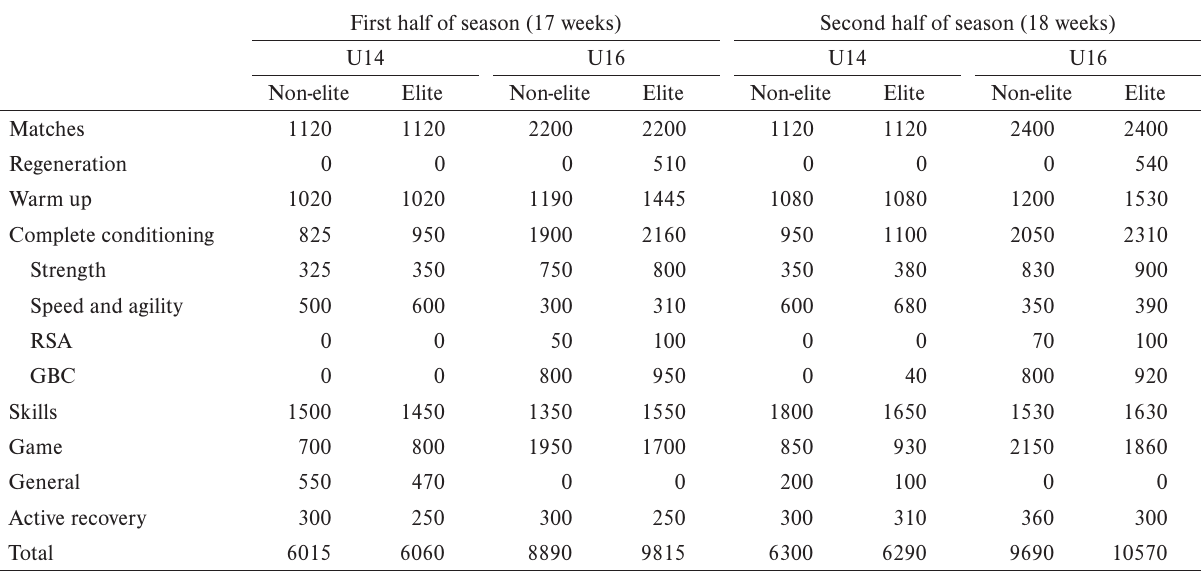
The workload expressed by total time (in minutes) of measured players during the